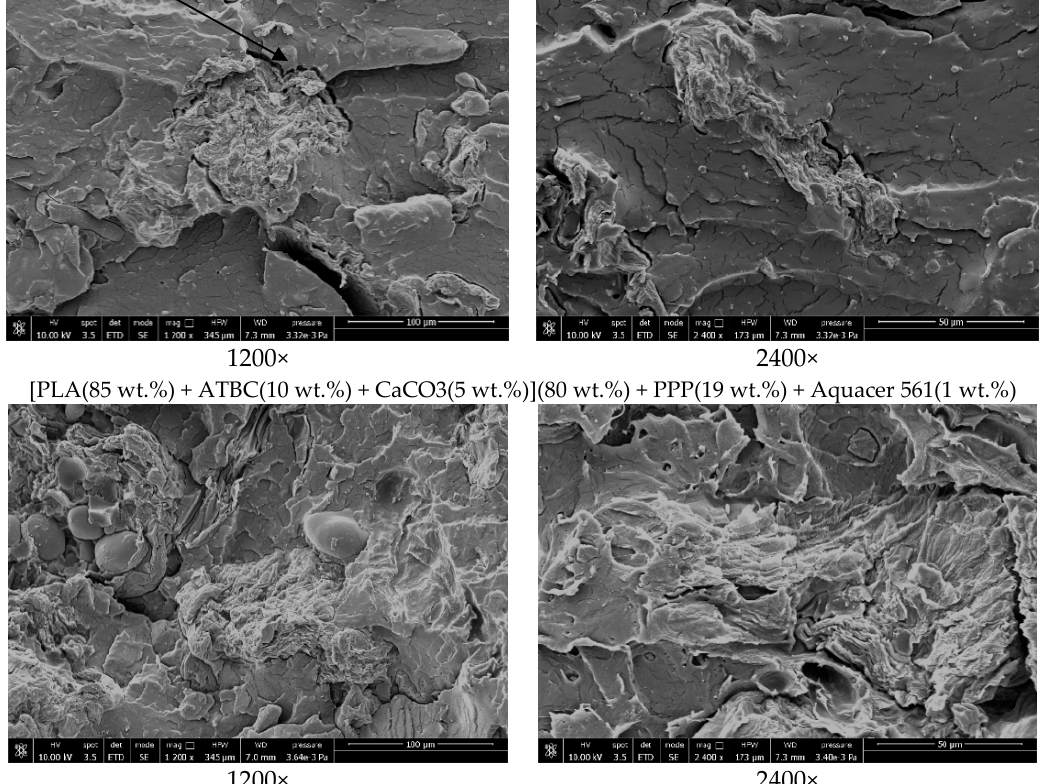
Figure 8. SEM images of the [PLA(85 wt.%) + ATBC(10 wt.%) + CaCO3(5 wt.%)](80 wt.%) + PPP(19 wt.%) + Aquacer 561(1 wt.%) and [PLA(85 wt.%) + ATBC(10 wt.%) + CaCO3(5 wt.%)](80 wt.%) + PPP(19 wt.%) + Aquacer 581(1 wt.%) biocomposites at the indicated magnification.